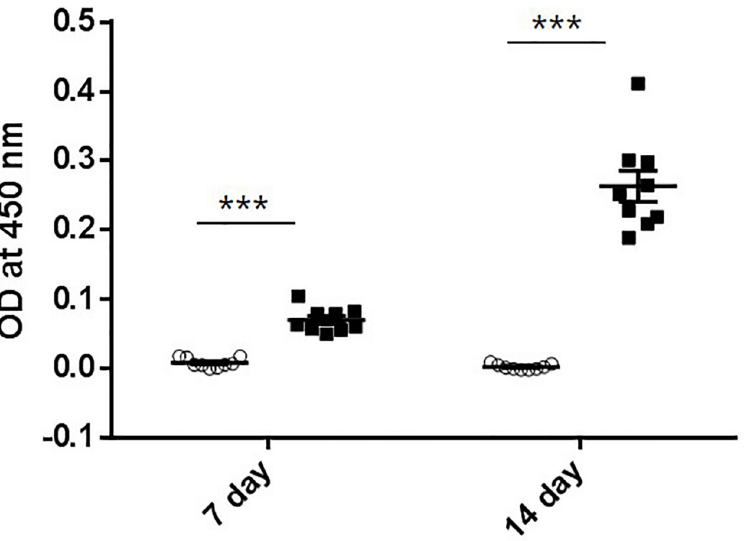
Fig 4. Titer values after the administration of MBP-Pro45-70-His6. 1000-fold diluted sera were used for titer measurement. Open circle ( � ) and closed square ( ■ ) indicate 0 and 20 mg/kg body wt administration of MBP-Pro45- 70-His6, respectively. Student‘s t -test was used to compare the mean difference. ��� . P <